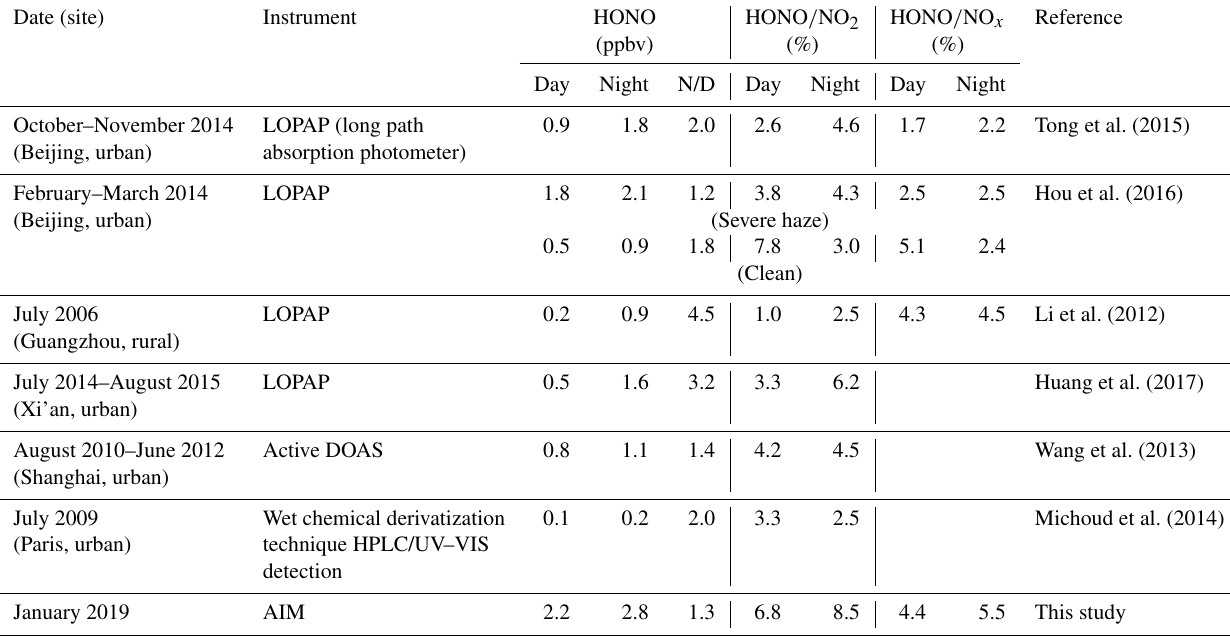
Table 2. Comparisons of the daytime and nighttime HONO level, HONO / NO 2 , and HONO / NO x mean values in Zhengzhou and other sites around the